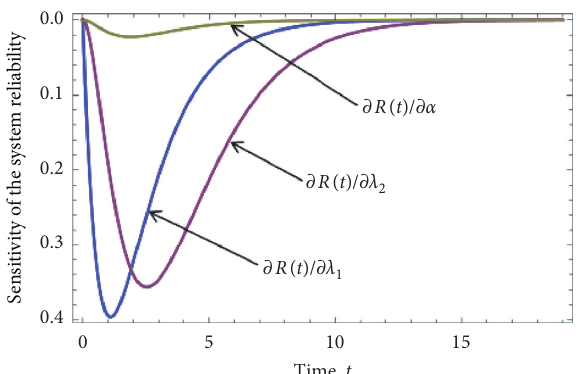
Table 6: Sensitivity and relativity sensitivity analysis of MTTF with